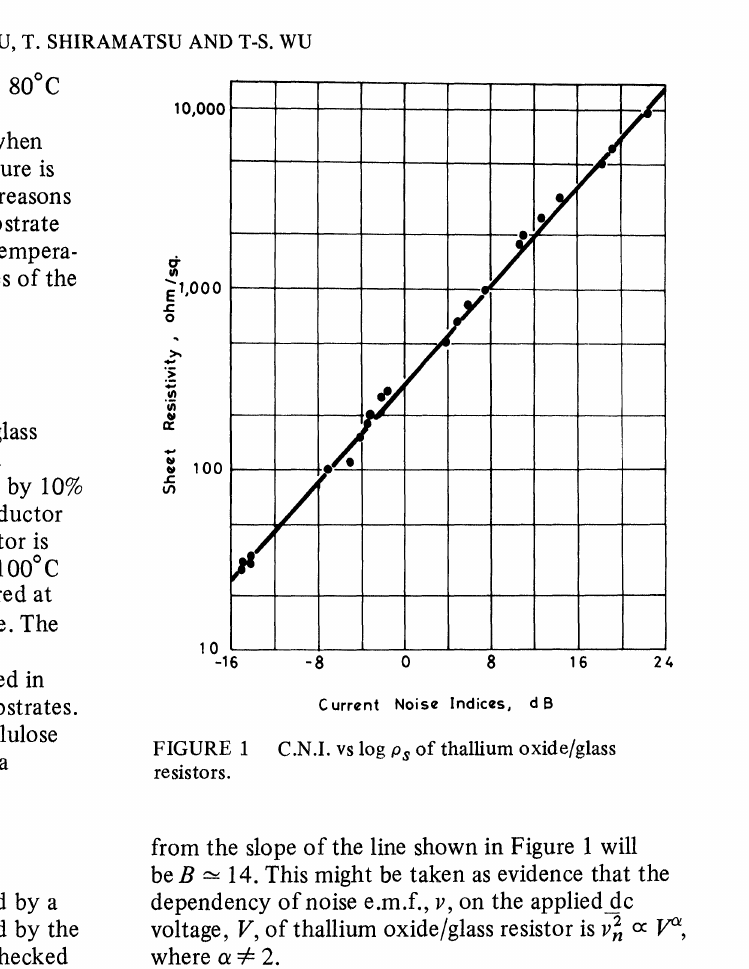
C.N.I. vs log Os of thallium oxide/glass FIGURE